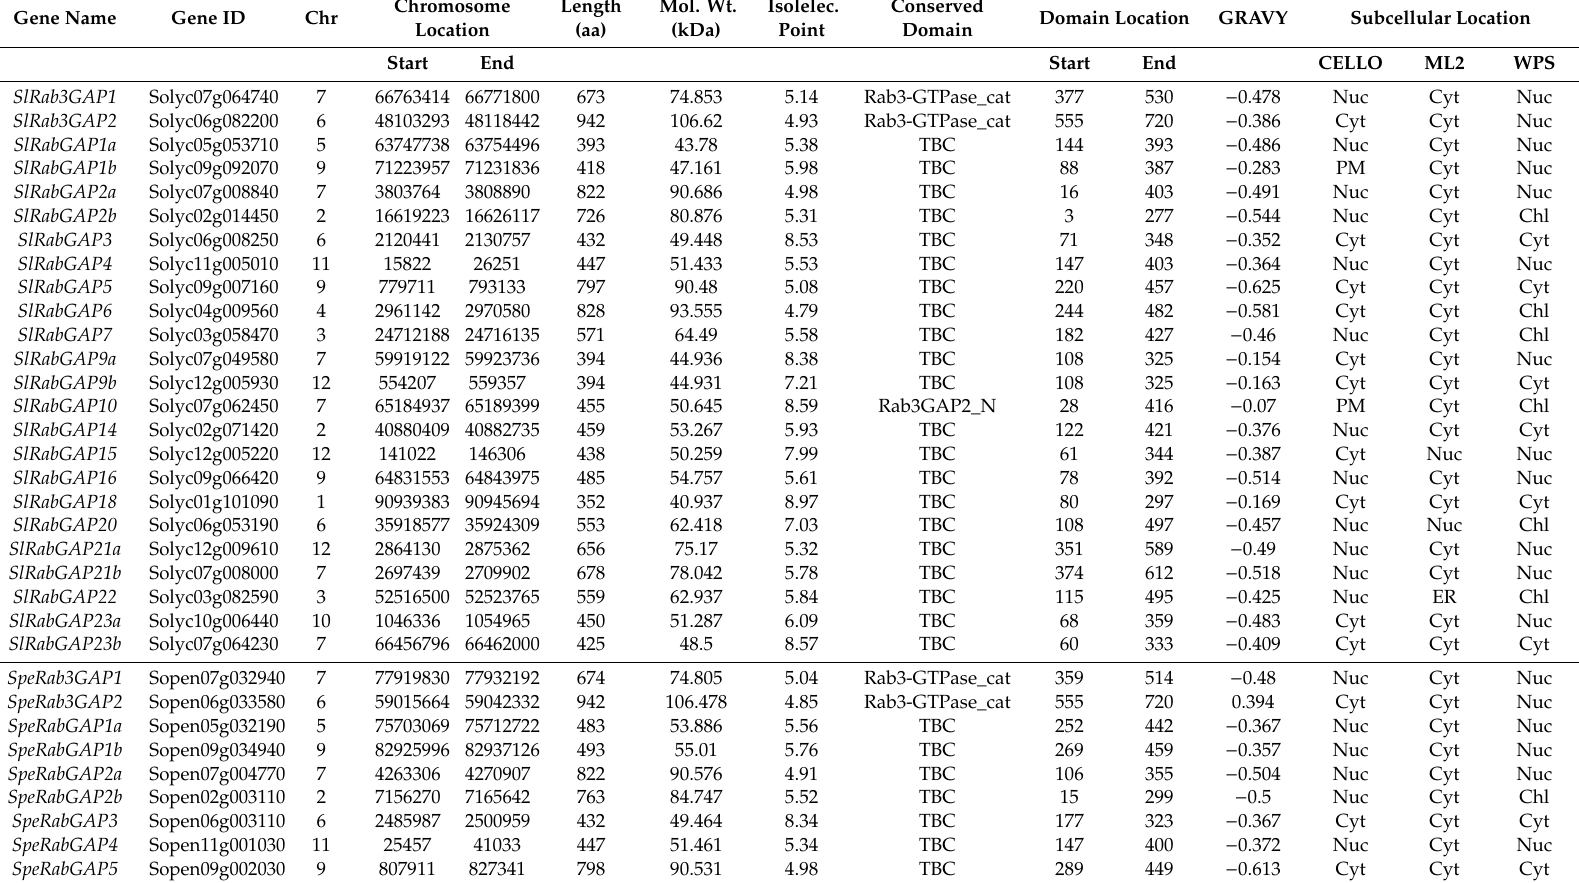
Table 1. List of RabGTPase activating proteins (RabGAP) genes found in domesticated and wild tomatoes and their physical and chemical characteristics. Data obtained from Sol Genomics Network database. Gene prefixes represent Solanum lycopersicum (Sl), Solanum pennellii (Spe), and Solanum pimpinellifolium (Spi). Subcellular location: ML2, MultiLoc2; WPS, Wolf PSORT. Nuc, Nuclear; Cyt, Cytoplasmic; Chl, Chloroplast; MP, Plasma Membrane; ER, Endoplasmic Reticulum; and Mit,